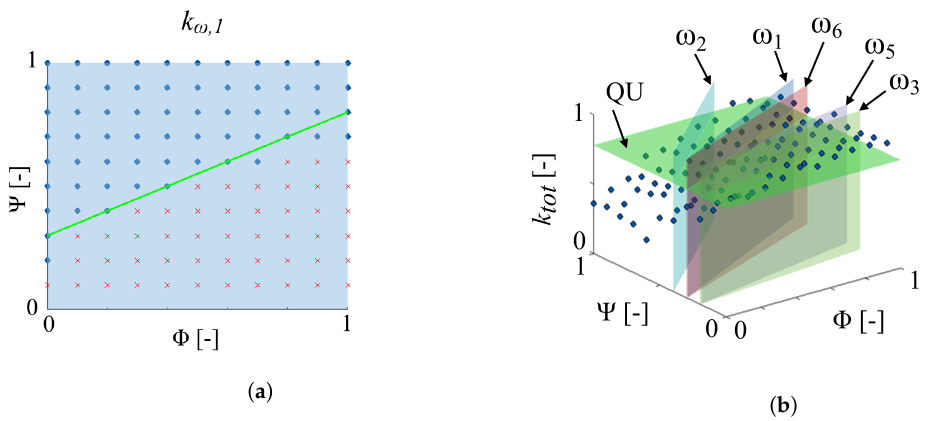
Figure 24. ( a ) k ω ,1 graph shown from above with a green separation line between manipulable (blue points) and non-manipulable (red crosses) combinations of Φ and Ψ . ( b ) Separation lines for each joint as a plane for determining the manipulable combinations of Φ and Ψ